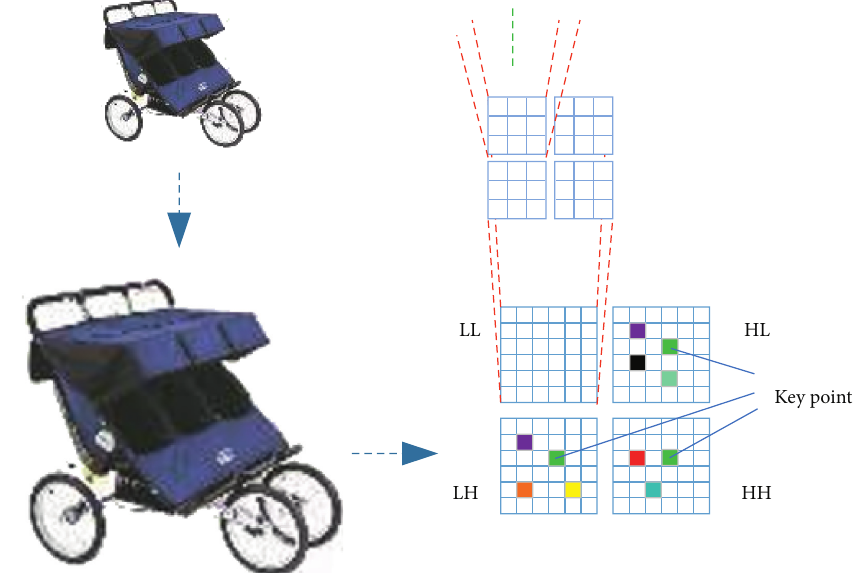
Figure 2: Schematic diagram of multiscale key point